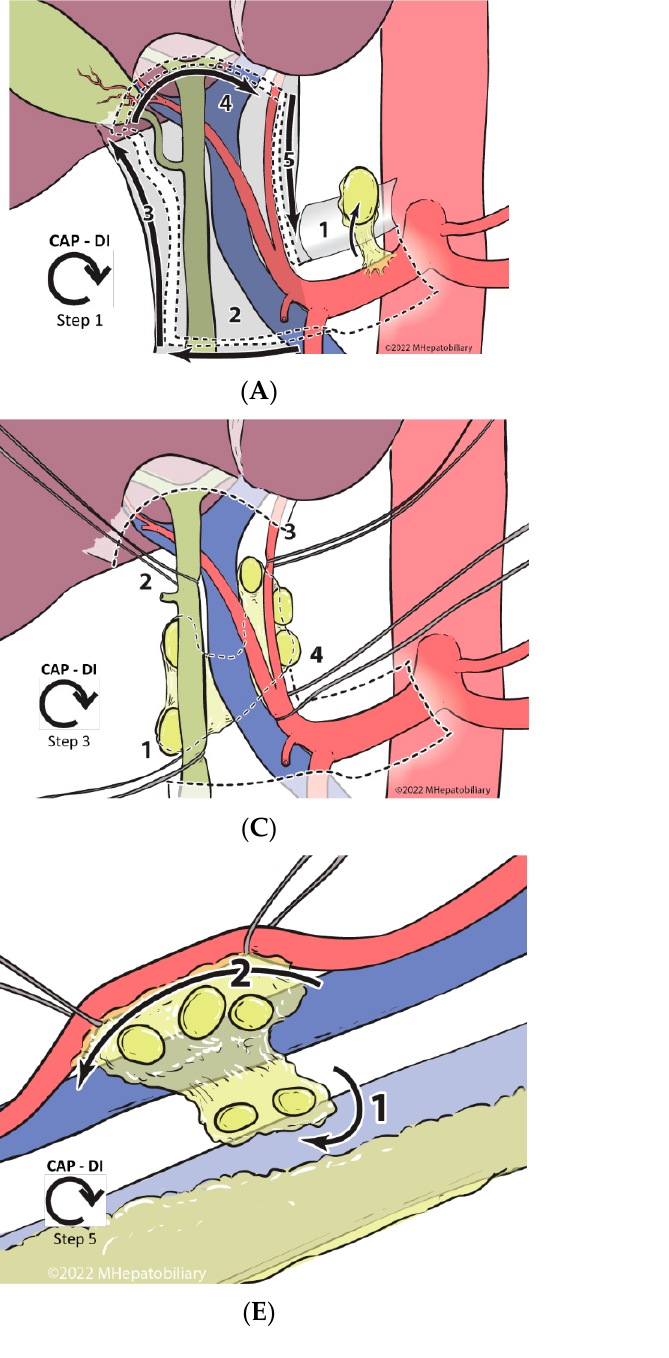
Figure 2. Technical steps of the Clockwise, Anterior ‐ to ‐ Posterior, Double ‐ Isolation (CAP ‐ DI) tech ‐ nique for portal lymph node dissection. ( A ). Entry and release: During this step, the peritoneal layer is entered above the hepatic artery lymph node, which is excised (1). This entry point is followed to release the peritoneal layer in a clockwise manner; starting across from the patient’s right (2), then cephalad along the bile duct (3), and subsequently across the hilum to the left side (4), to end cau ‐ dally towards the entry point by following the left and proper hepatic arteries (5). ( B ). Clockwise anterior lymph node dissection: Following a clockwise approach and starting at the most inferior end of the hepatoduodenal ligament, the fatty areolar and lymphatic tissue in substation 2 between the proper hepatic artery and the common bile duct, and immediately anterior to the portal vein, is removed (1). Often it is necessary to sacrifice the right gastric vessels to retrieve the tissue in this location. While dissecting tissue off the surface of the portal vein, care must be taken to avoid injury to venous tributaries entering the anterior surface of the portal vein (i.e., coronary vein). Similarly, while it is important to excise all the tissue between the named structures, one should minimize dissection on the medial side of the bile duct to avoid injury to the 9 o’clock vessel. Subsequently, substation 3 is dissected along the cystic duct and within Calot’s triangle (2). The cystic duct, artery,